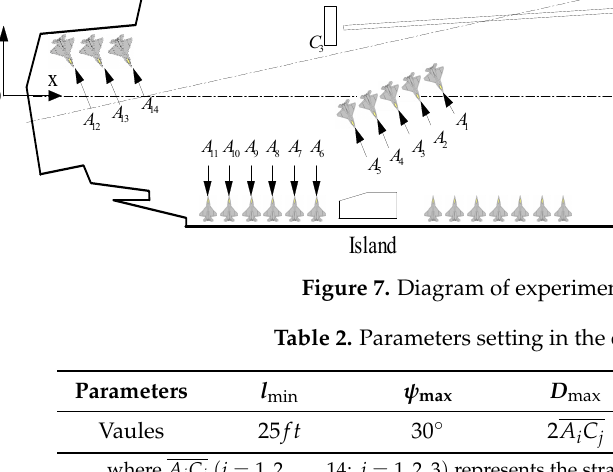
Figure 8. The schedule of launching mission.